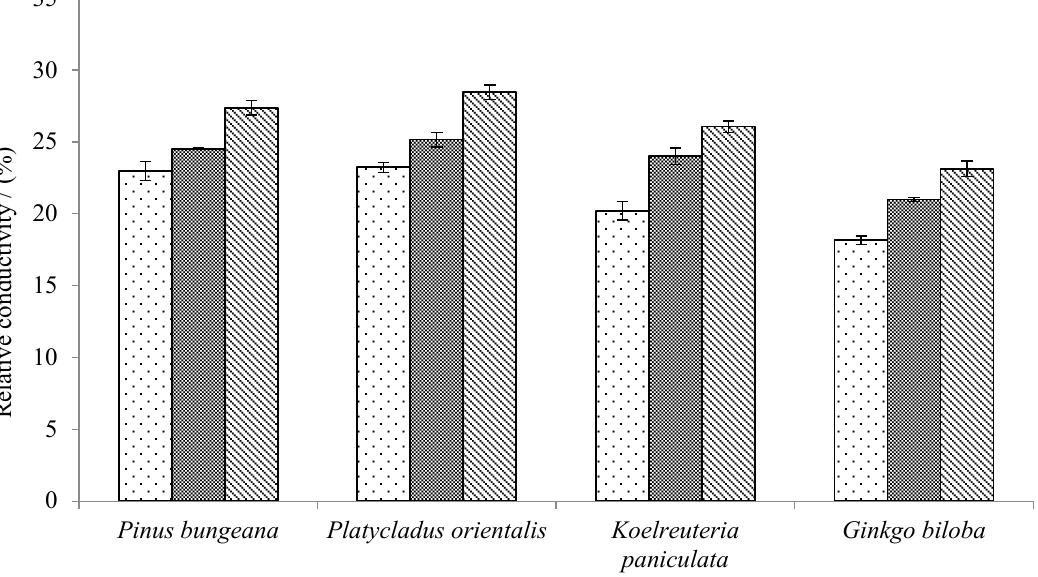
Figure 4. The variation in trees’ relative conductivity under different OZONE concentrations.